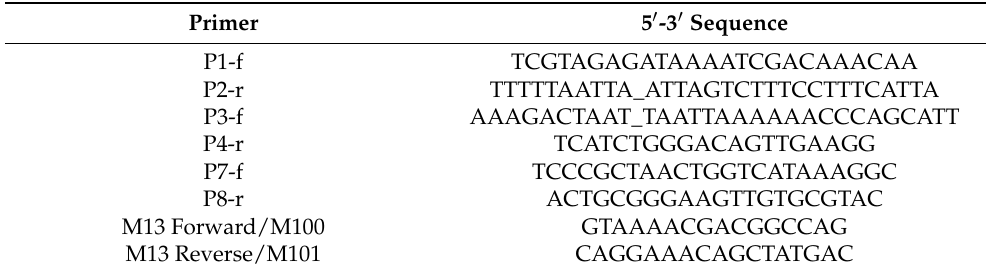
Table 1. Primers used for generation of EGD-e ∆ inlF . Primer 5 (cid:48) -3 (cid:48)